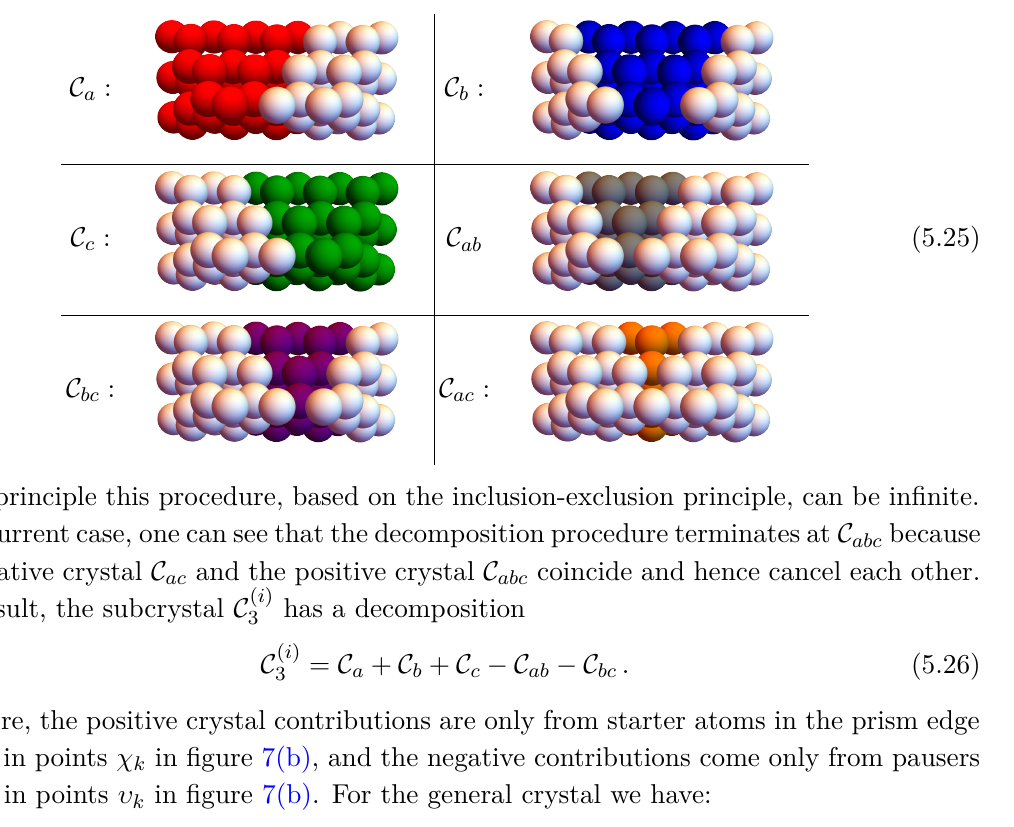
Figure 7 . (a) The crystal for the infinite chamber C ( i ) m of the resolved conifold, with m = 3 . (b) The locations of the starters at x with k = 1 , 2 , . . . , m and the pausers at y with k = 1 , 2 , . . . , m − 1 . k k crystal whose leading atom is at the position x . Their intersections gives the three negative (canonical) crystals at level-1: C , C , C . Then the intersection of theses three negative ac ab bc crystals at level-1 gives one positive crystal at level-2: C abc